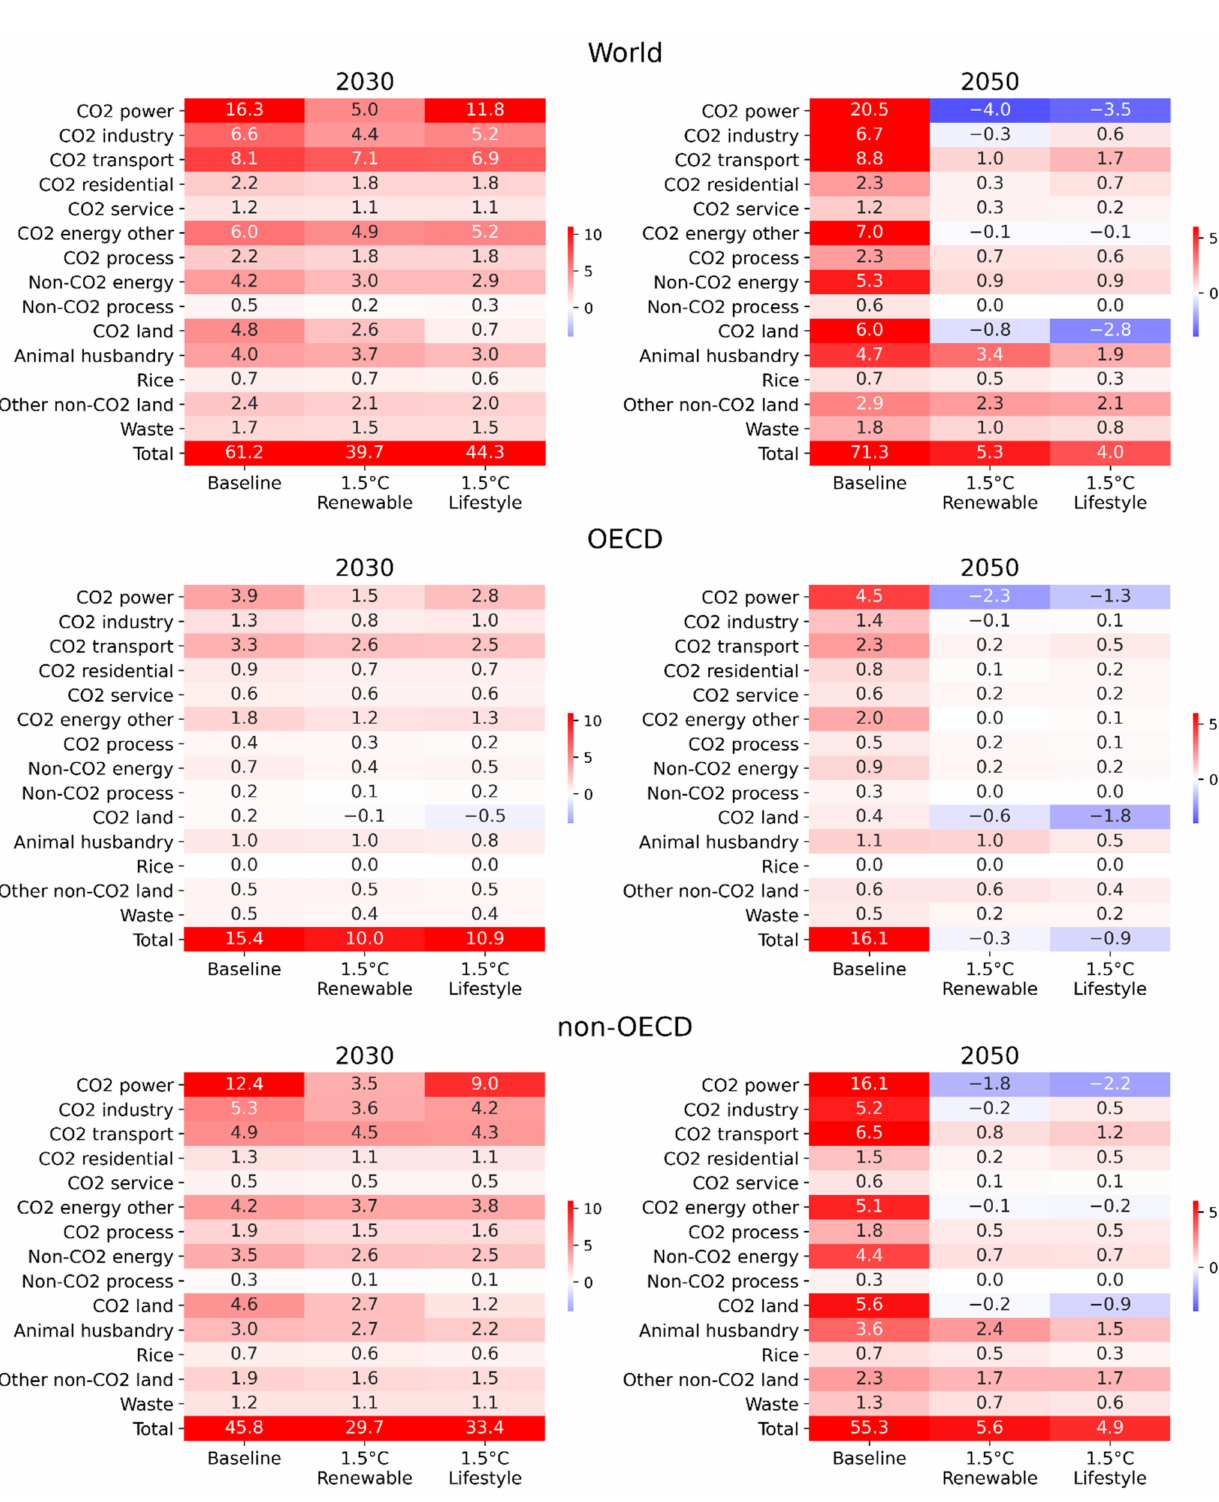
Figure 1. Total greenhouse gas emissions by emission source in 2030 and 2050 in Gt CO 2 -eq. (using IPCC AR4 100-year global warming potentials [24]). The emission sources combined account for around 97% of global GHG emissions in recent years